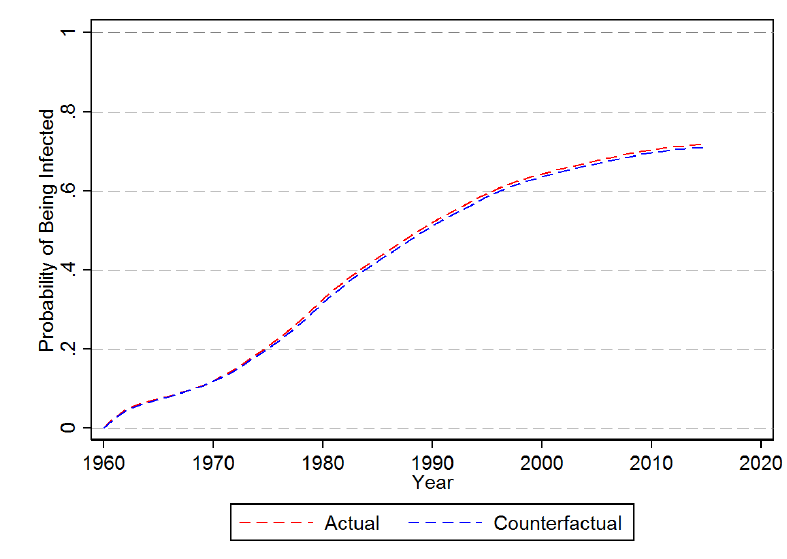
Figure 5. Probability of First Time Infection—No Long Distance Dispersal. Note: This figure provides the counter-factual prediction of the impact assuming of no LDD as estimated from the Cox Proporational Hazard Model in Equation